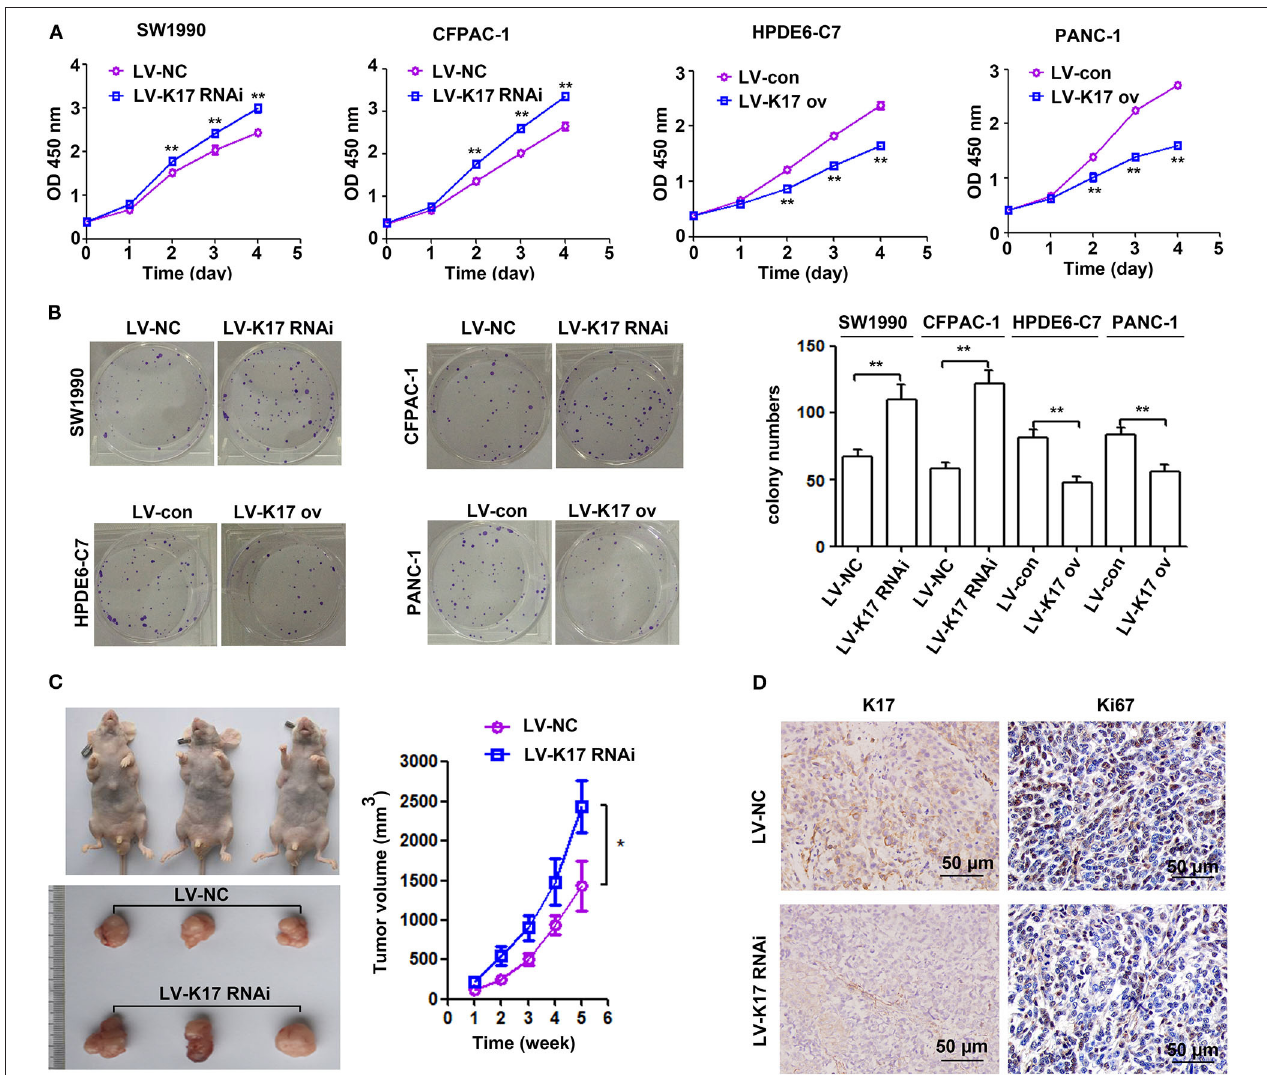
FIGURE 4 | K17 inhibited pancreatic cancer cell growth in vitro and in vivo . (A,B) The proliferation ability of stable K17 silenced SW1990 and CFPAC-1 cells and stable K17 upregulated HPDE6-C7 and PANC-1 cells was determined by CCK-8 assays (A) and colony formation assays (B) . (C) K17 inhibition significantly elevated tumor growth yielding larger tumor volumes than those of the LV-NC group. (D) Ki67 IHC analysis of tumors from nude mice. × 200 Scale Bar = 50 µ m. * P < 0.05, and ** P < 0.01.